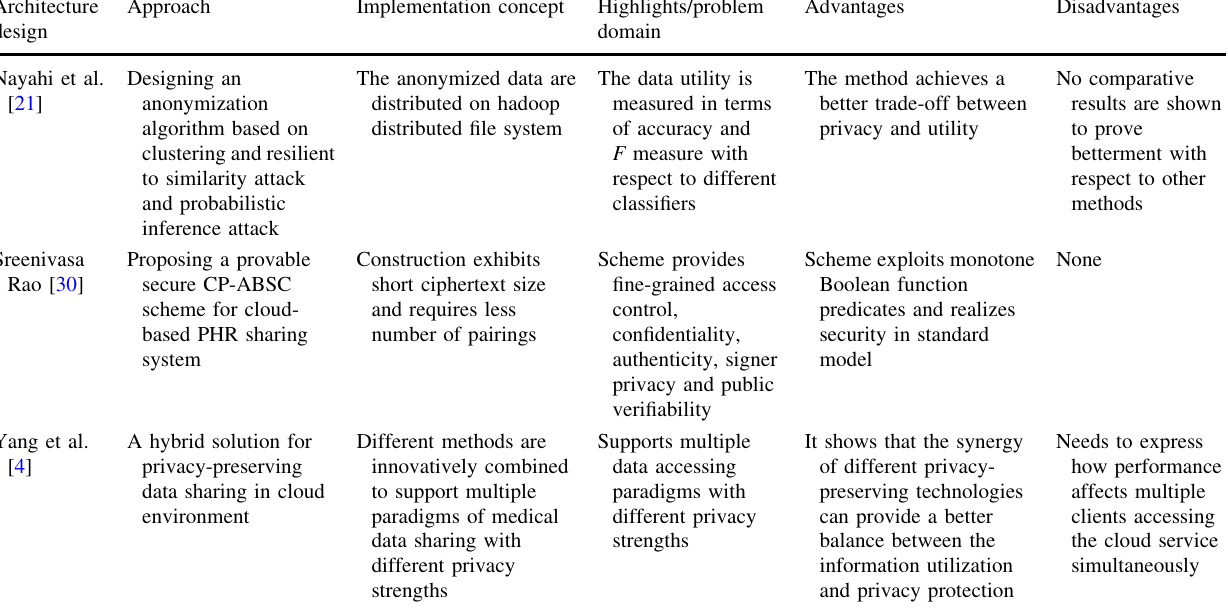
Table 4 Comparison of anonymization-based evaluation approaches Architecture